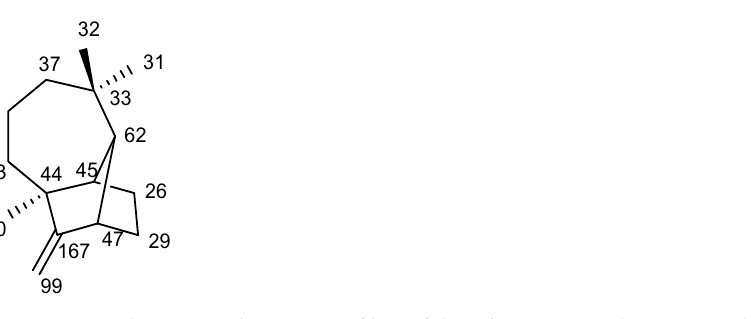
Figure 2. Two-dimensional structure of longifolene/junipene with NMR results.